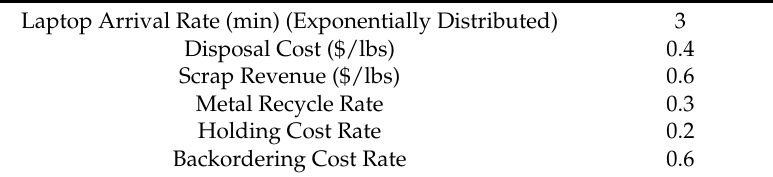
Table A7. Production and cost